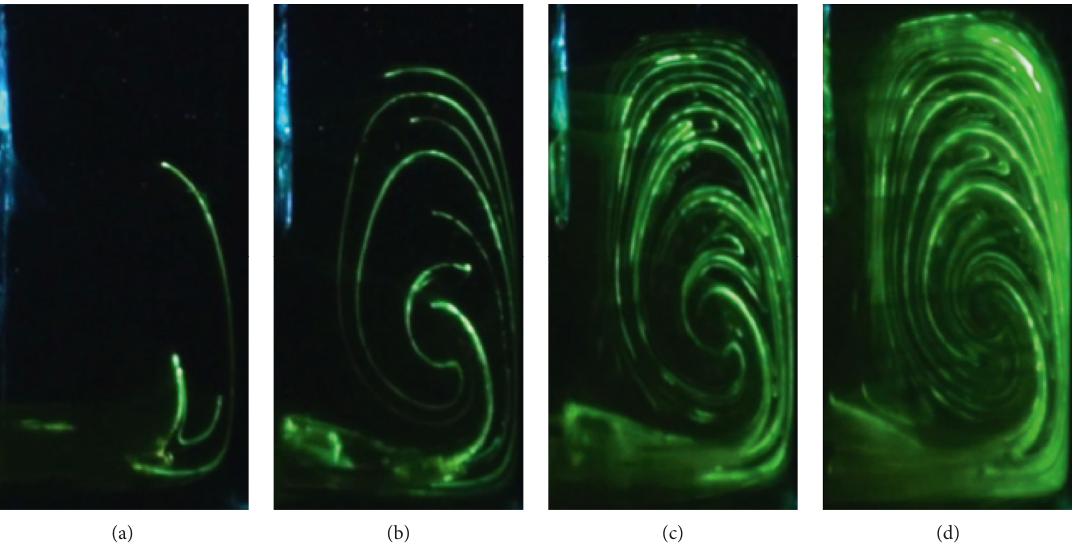
Figure 5: Streak lines generated by the HB-type impeller. (a) Rotation � 4; (b) rotation � 6; (c) rotation � 10; (d) rotation � 14.